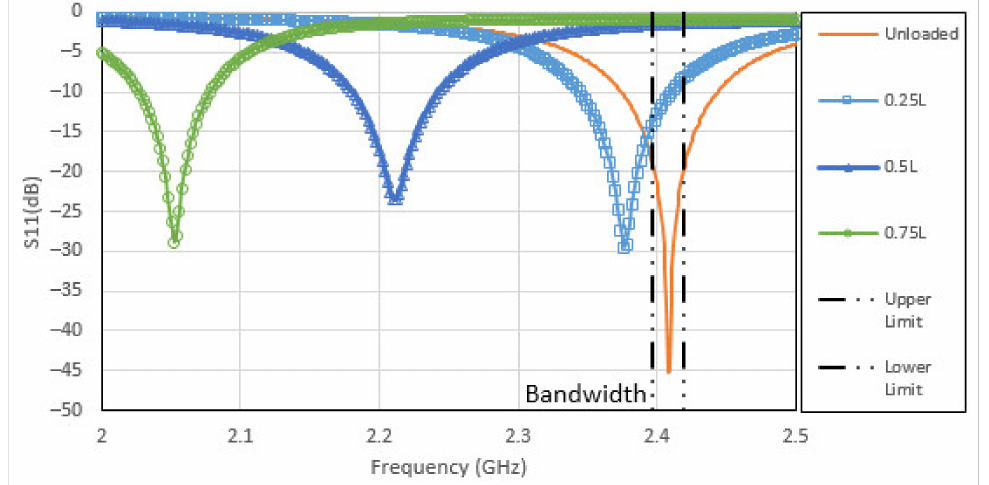
Figure 15. CLAS’s S11 plotted for the three antenna locations (0.25 L, 0.5 L, 0.75 L as shown in Figure 14) on the specimen experiencing twist